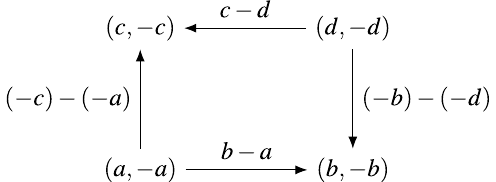
Figure 5. The structure of Coordination in a zero-sum game. For this to be possible, we would need c − d > 0 , b − a > 0 , ( − b ) − ( − d ) > 0 and ( − c ) − ( − a ) > 0 , giving an impossible cycle d > b > a > c > d